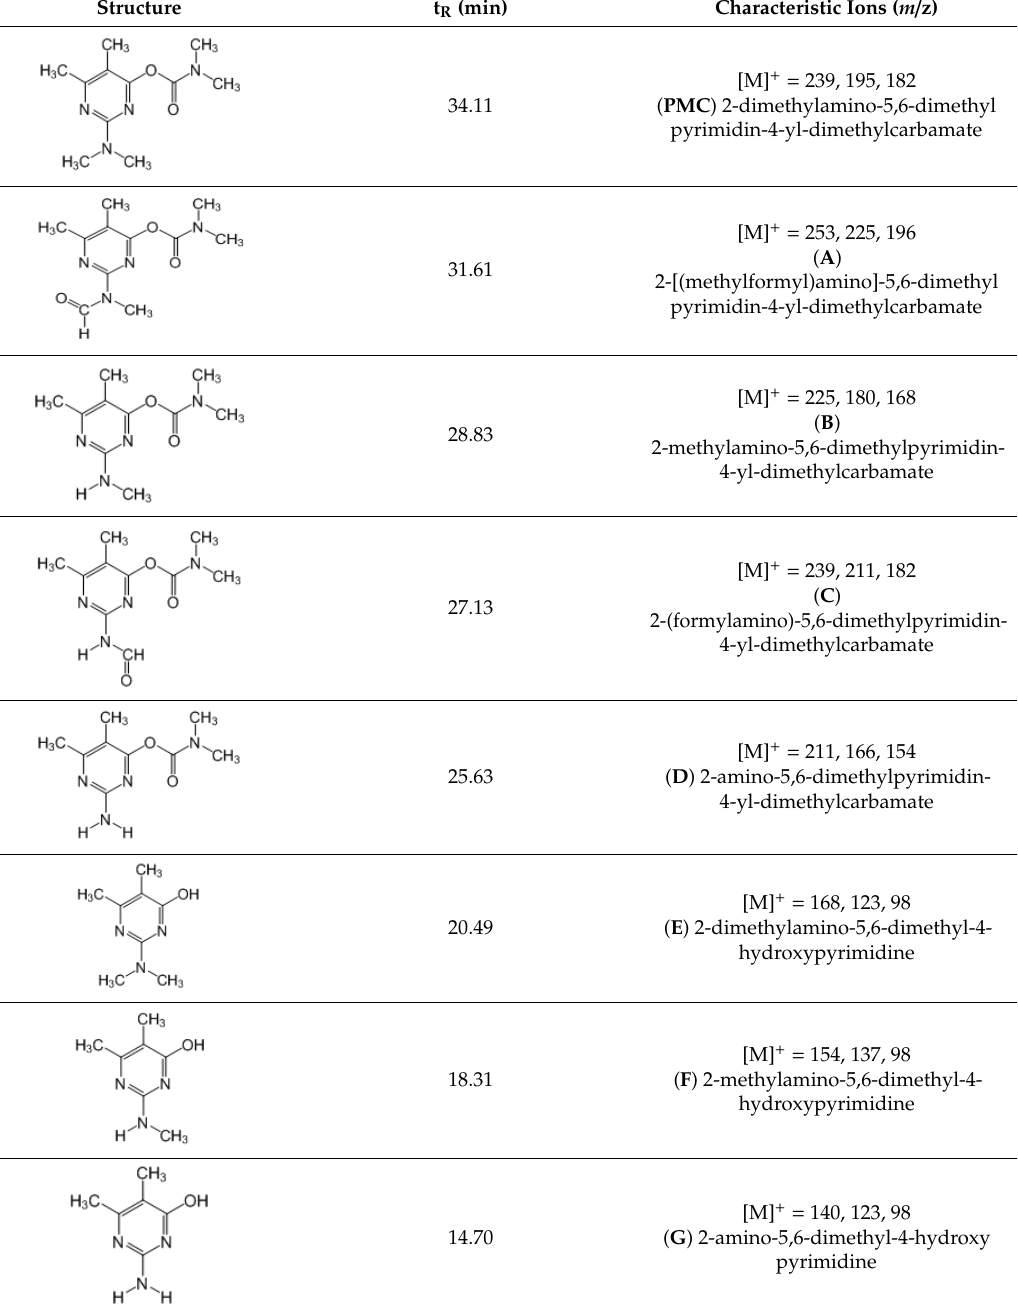
Figure 13. HPLC chromatogram obtained for pirimicarb solution (10 mg L − 1 ) after 16 h of irradiation with visible light in the presence of 1.0 wt% Pt/AgInS 2 catalyst (1.0 g L − 1 ). Table 4. Identification of the intermediates from the photodegradation of pirimicarb by LC/MS. Structure t R (min) Characteristic Ions ( m /z)